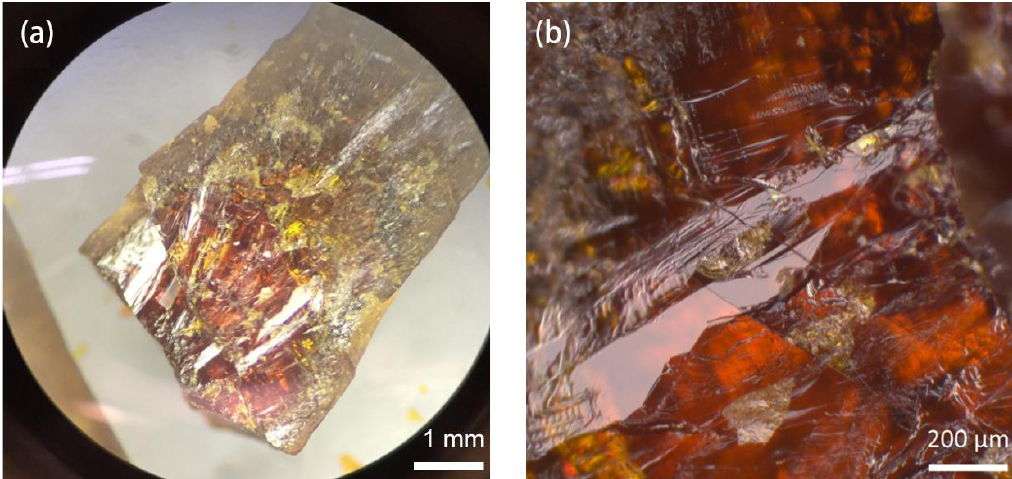
Figure 2. ( a ) Photograph of as-grown boule of TbInO 3 . ( b ) The cleaved surface of TbInO 3 crystal.